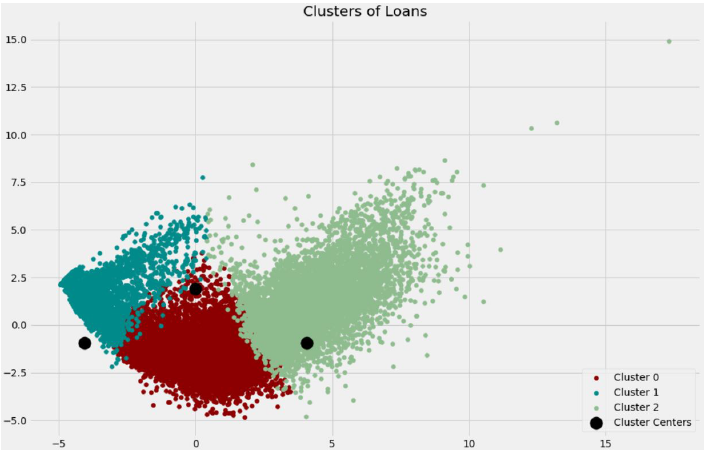
Figure 8. Visual representation by the PCA method of the three clusters present in the resample after analyse the centers [1].